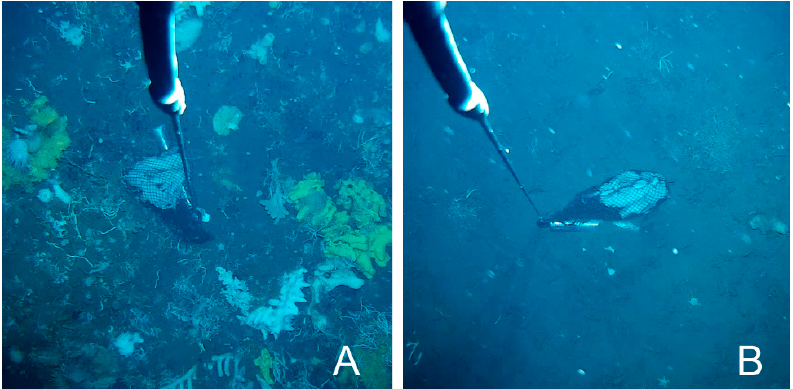
Figure 3. Examples of seafloor features. (A) Mixed substrate with high (90%) benthos coverage (Terra Nova Bay, site 05). (B) Soft substrate with low (10%) benthos coverage (Terra Nova Bay, site 06).